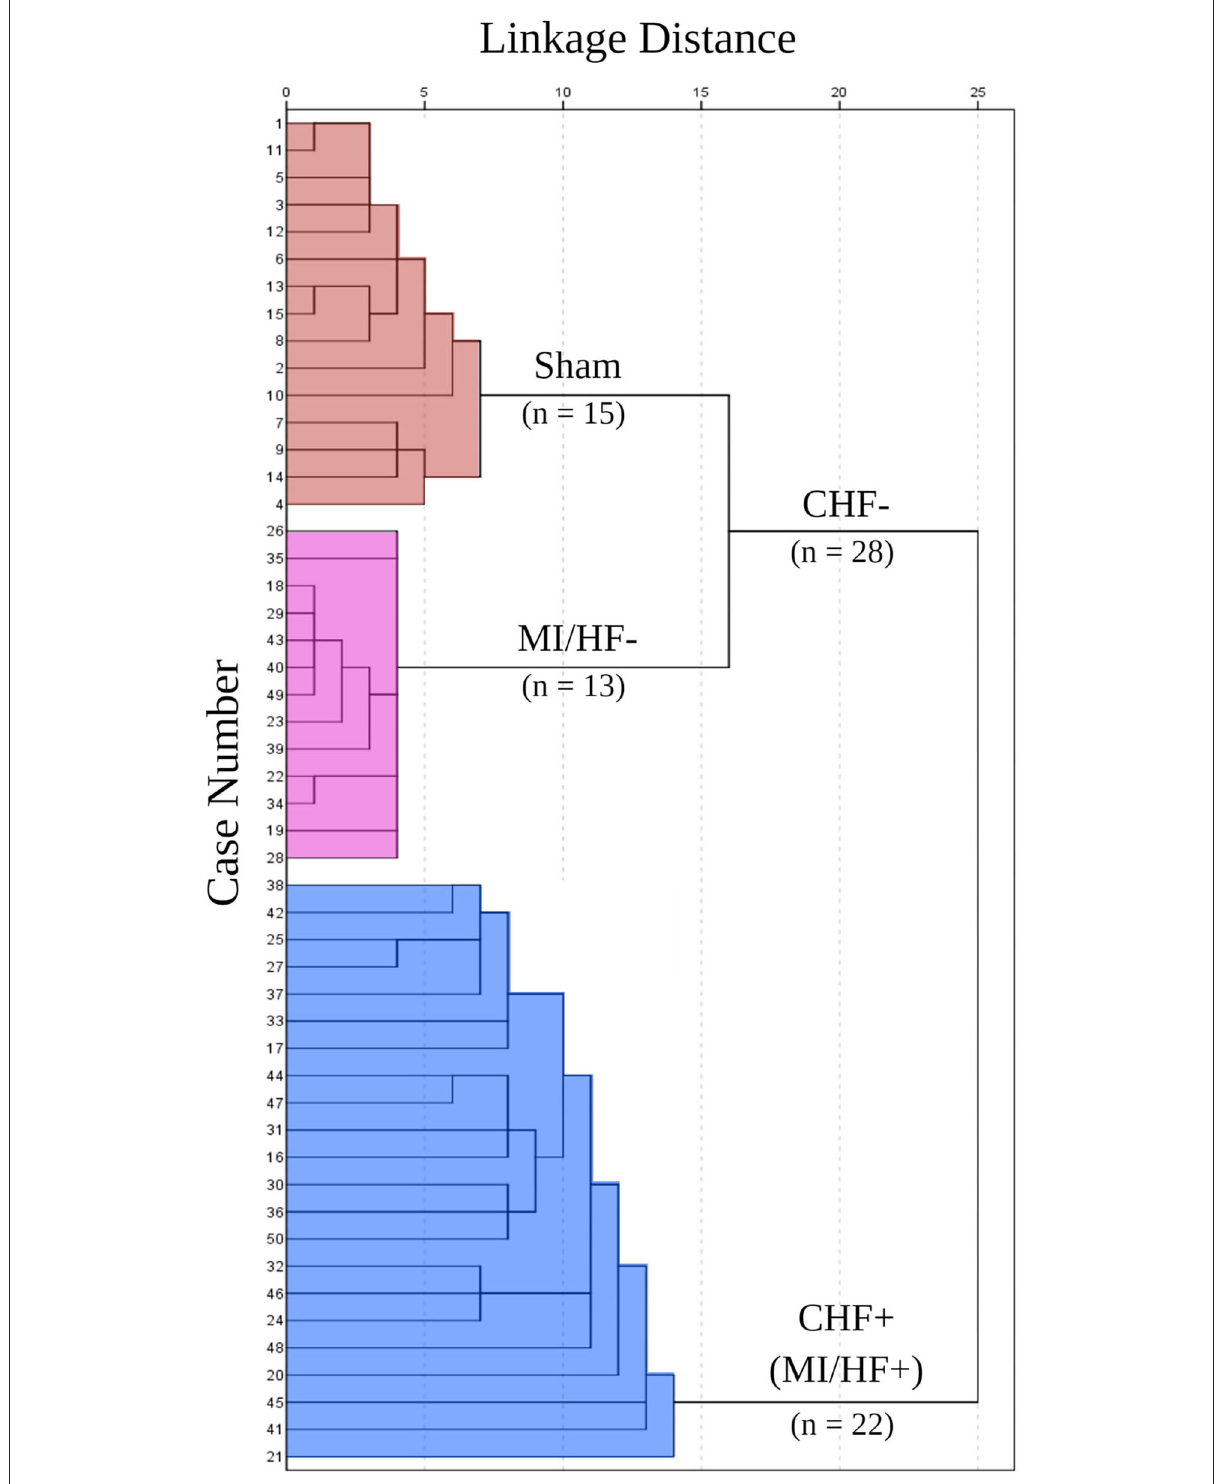
FIGURE2 J-tree Cluster analysis. All animals were included in the analysis as cases. Ten echocardiographic variables were used in the cluster analysis: left ventricular internal dimension at end-diastole (LVIDd), left ventricular internal dimension at end-diastole to body weight ratio (LVIDd/BW), left ventricular internal dimension at end-systole (LVIDs), ejection fraction (EF), fractional shortening (FS), left atrium to body weight ratio (LA/BW), left atrium to aorta ratio (LA/Ao), early diastolic transmitral flow velocity (E), early to late diastolic transmitral flow velocities ratio (E/A), and isovolumetric relaxation time